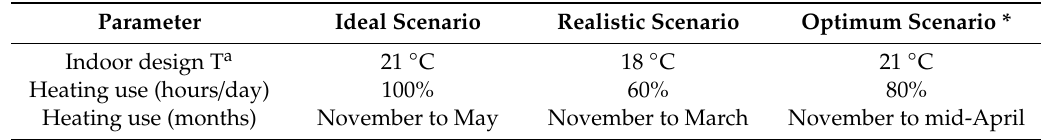
Table 2. Parameters of the proposed scenarios.